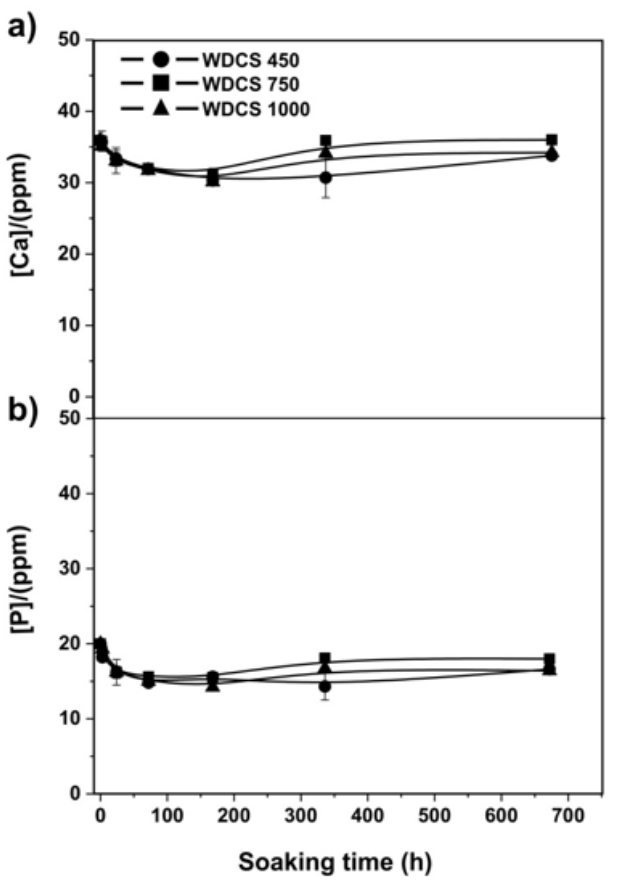
Figure 8. Bioactivity behavior of the carbon scaffolds: Changes of the Ca ( a ) and P ( b ) concentrations vs. soaking time in WDCS450 (Circle), WDCS750 (square) and WDCS1000 (triangle).